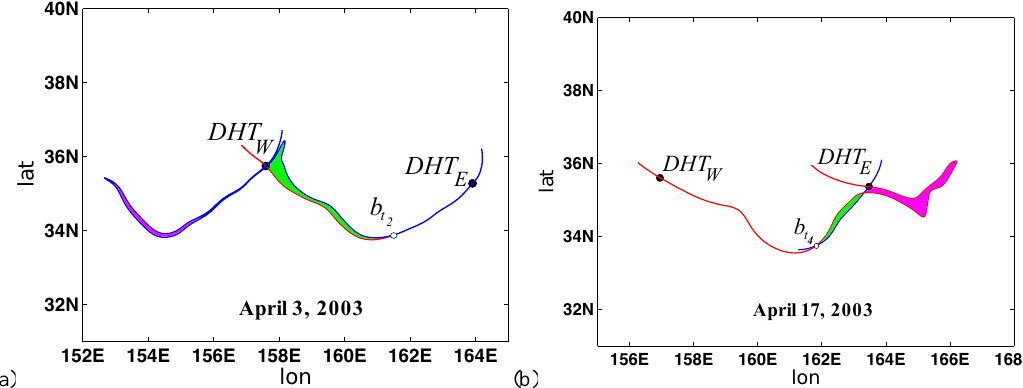
Fig. 22. Turnstile lobes across the main stream at days 3 April and 17 April 2003. The magenta area evolves from south to north while the green area does from north to south. (Figure taken from Mendoza et al., 2010).